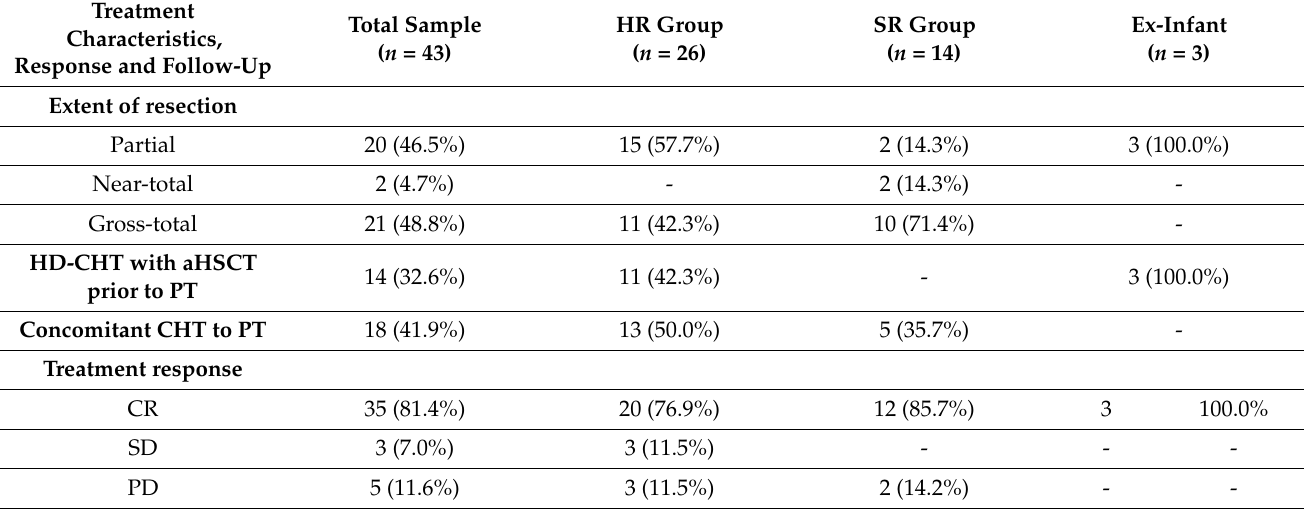
Table 2. Surgery, chemotherapy, treatment response, and follow-up